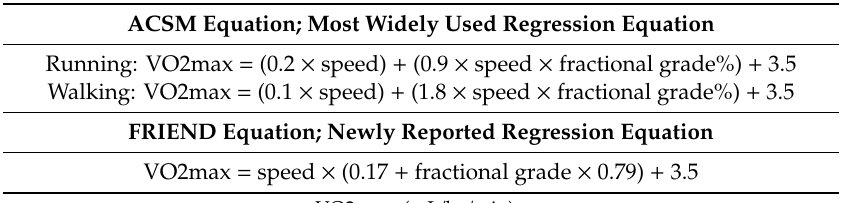
Table 1. Two regression equations for estimating cardiorespiratory fitness (CRF) with treadmill parameters. ACSM Equation; Most Widely Used Regression